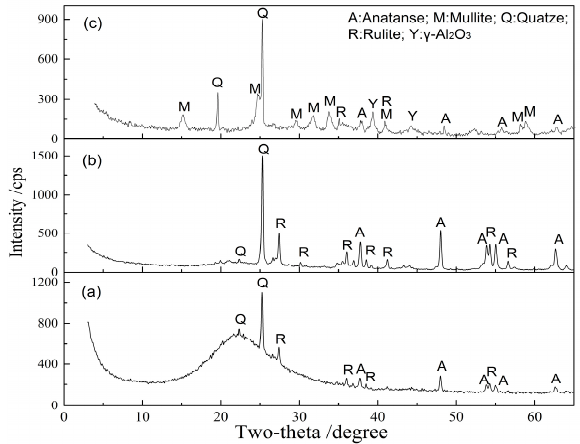
Figure 4. XRD patterns of leaching residues from activated kaolinite ( a ) residue from acid leaching of kaolinite activated at 900 °C for 15 min; ( b ) residue from alkali leaching of acid-leached residue; ( c ) residue from alkali leaching of kaolinite activated at 1150 °C for 15 min.